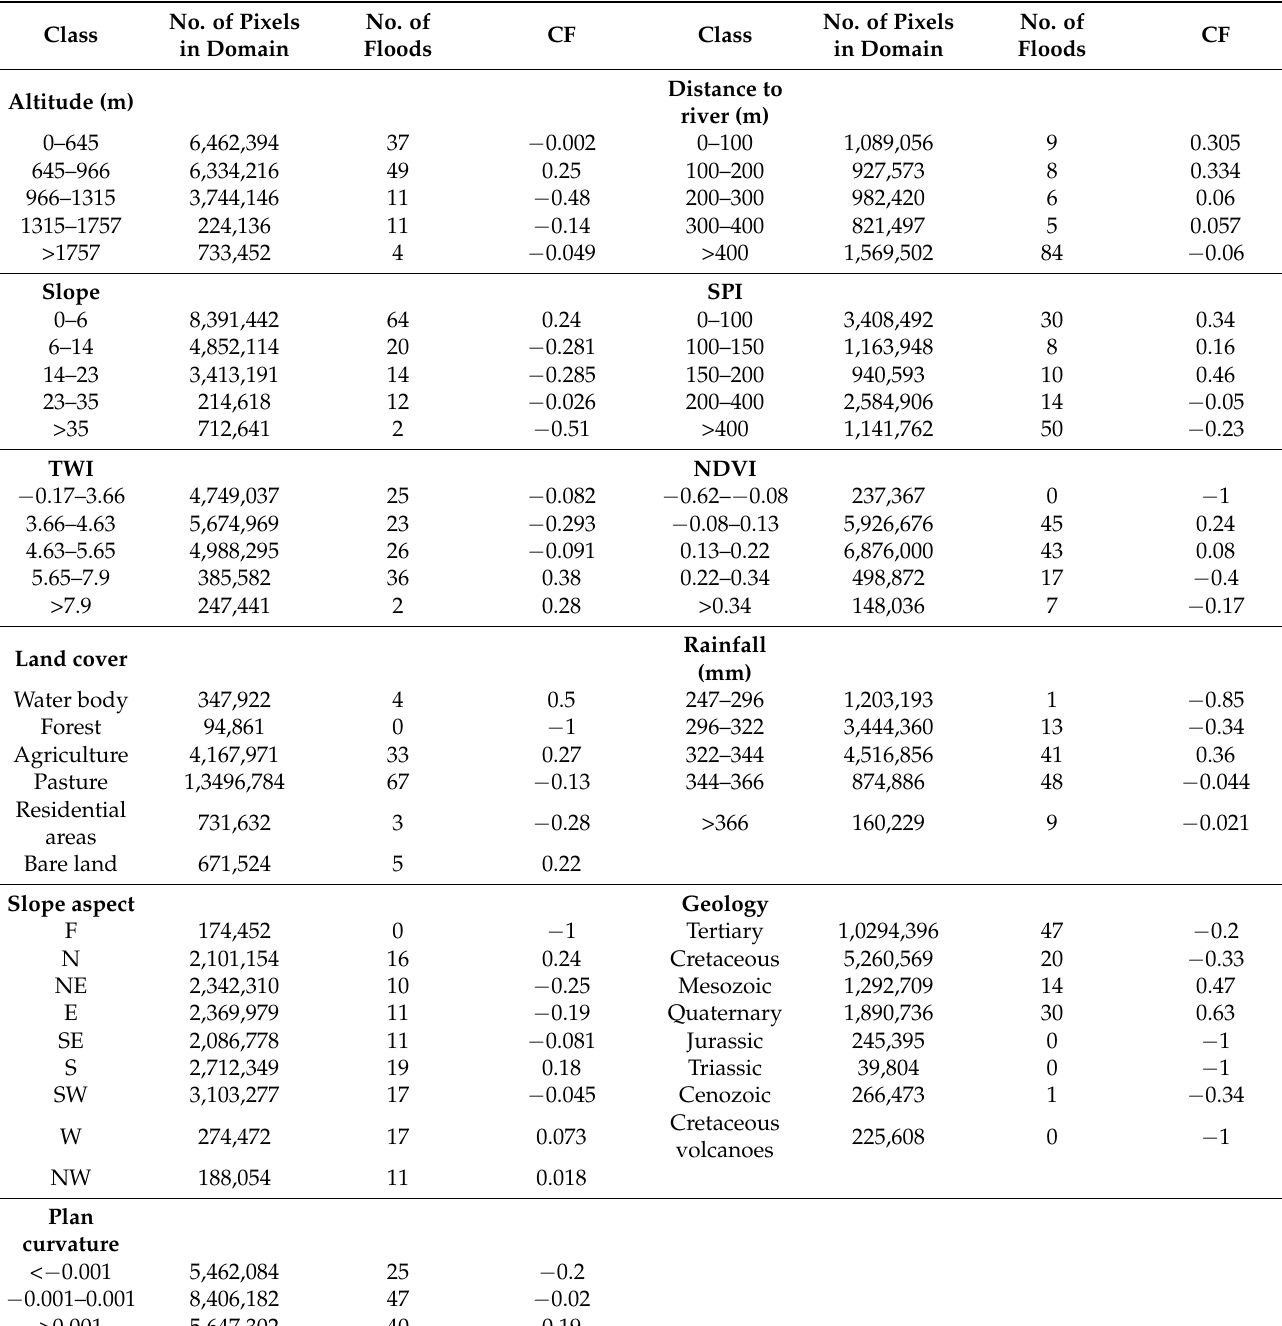
Table 2. Weights obtained with the CF